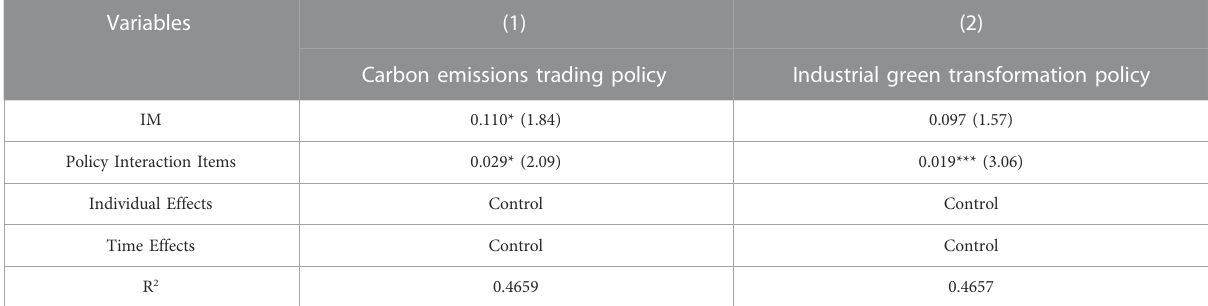
TABLE 5 Heterogeneity analysis of different policies.